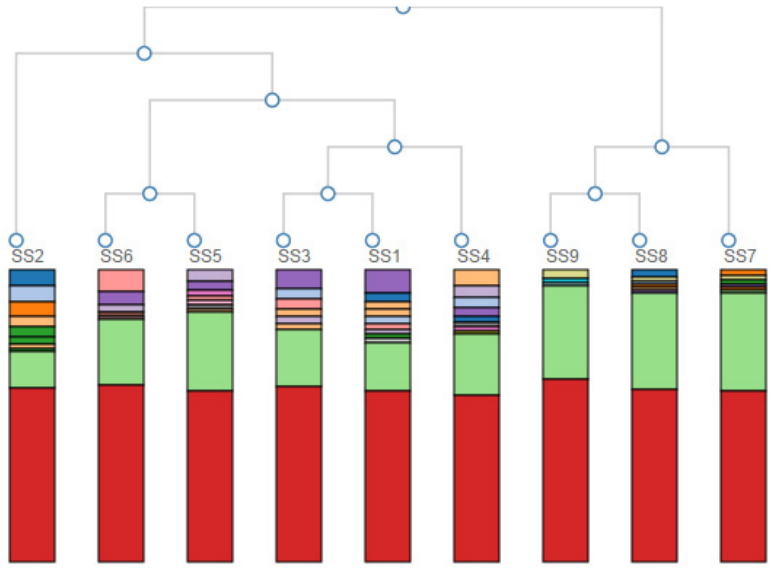
Figure 3. Hierarchical clustering of the samples based on the genus-level classification. Colours represent different Genera—the red colour reads as unidentified at the genus level (around 50%).